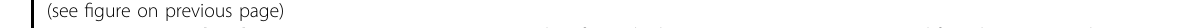
Fig. 6 TSP50 acetylated PKM2 at K433 site. A Vectors encoding for multiple mutant PKM2 were constructed for subsequent analysis using a site- directed mutagenesis kit. B PKM2 K62R, K305R or K433R mutant vector was co-transfected with TSP50 into Huh7 cells. The cell was harvested and followed by IP with anti-Flag and PKM2 activity analysis. C – E The pcDNA3.1-TSP50 and Flag-PKM2 WT, Flag-PKM2K62R, Flag-PKM2 K305R or Flag- PKM2 K433R mutant plasmids were co-transfected into cells, respectively. The level of PKM2 K433 acetylation was detected using an anti-PKM2 K433ac antibody. F – R Acetylated mimic of PKM2 (PKM2-K433Q) transfected in cell lines de fi cient of TSP50, the PKM2 activity, cell viability, BrdU absorbance, glucose consumption, lactate production and ATP levels were detected. All aerobic glycolysis values were normalized to protein levels. N = 3 biologically independent replicates. t -Test statistical analysis was used. Data were presented as means ± s.d. *P < 0.05, **P < 0.01. ns, no signi fi